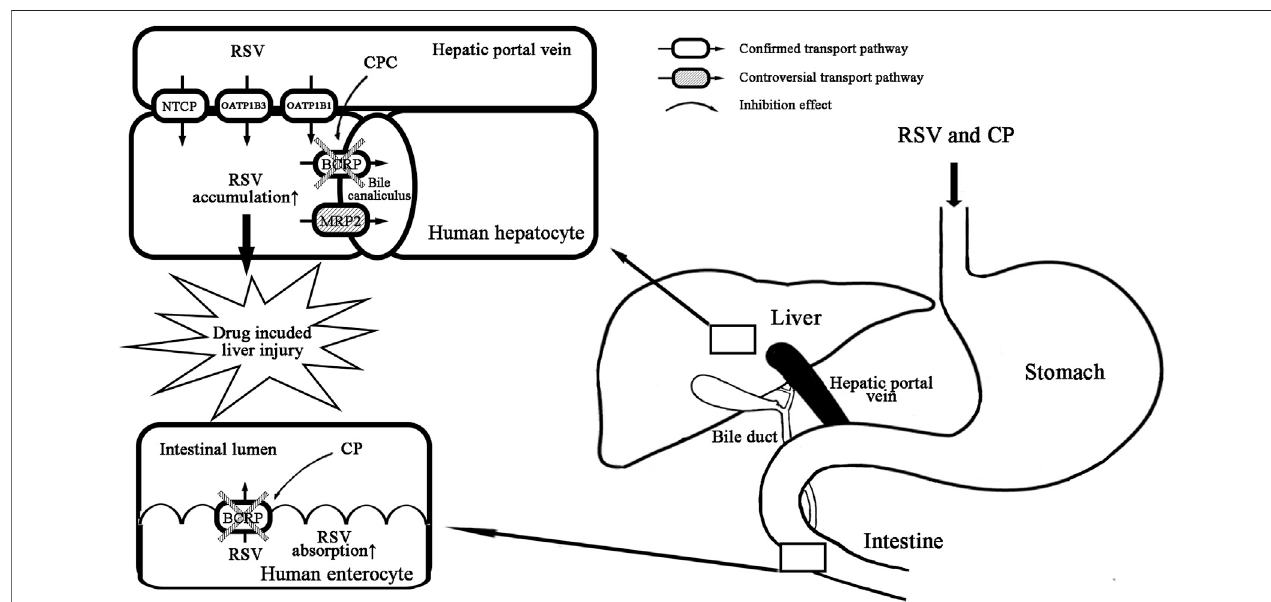
FIGURE 7 | Proposed mechanism of RSV-CP DDI. CP inhibits intestinal BCRP ef fl ux, and CPC inhibits hepatic BCRP ef fl ux of RSV.